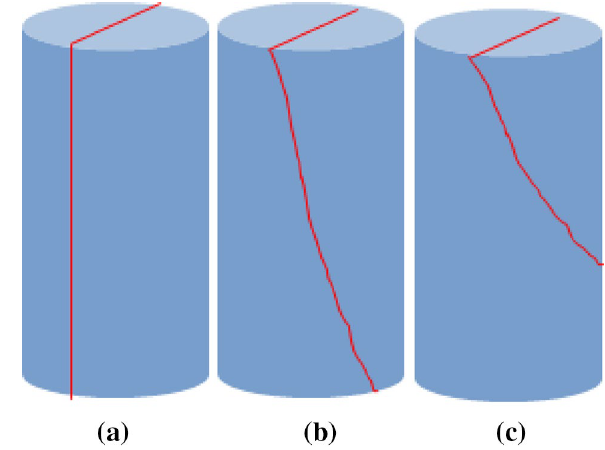
Fig. 1 Several failure forms of fractures with different rupture